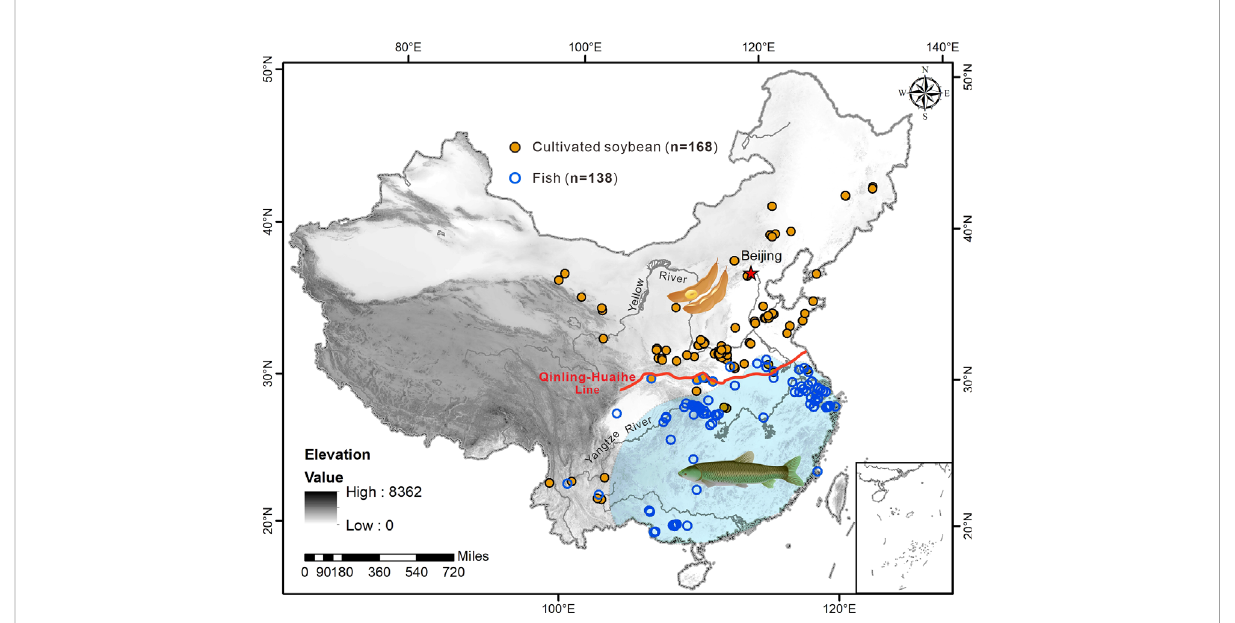
FIGURE 3 Contrastive patterns of soybeans and fi sh in the Neolithic and Bronze Age across China. The orange solid and blue hollow circulars in denote sites of cultivated soybeans and fi shes,